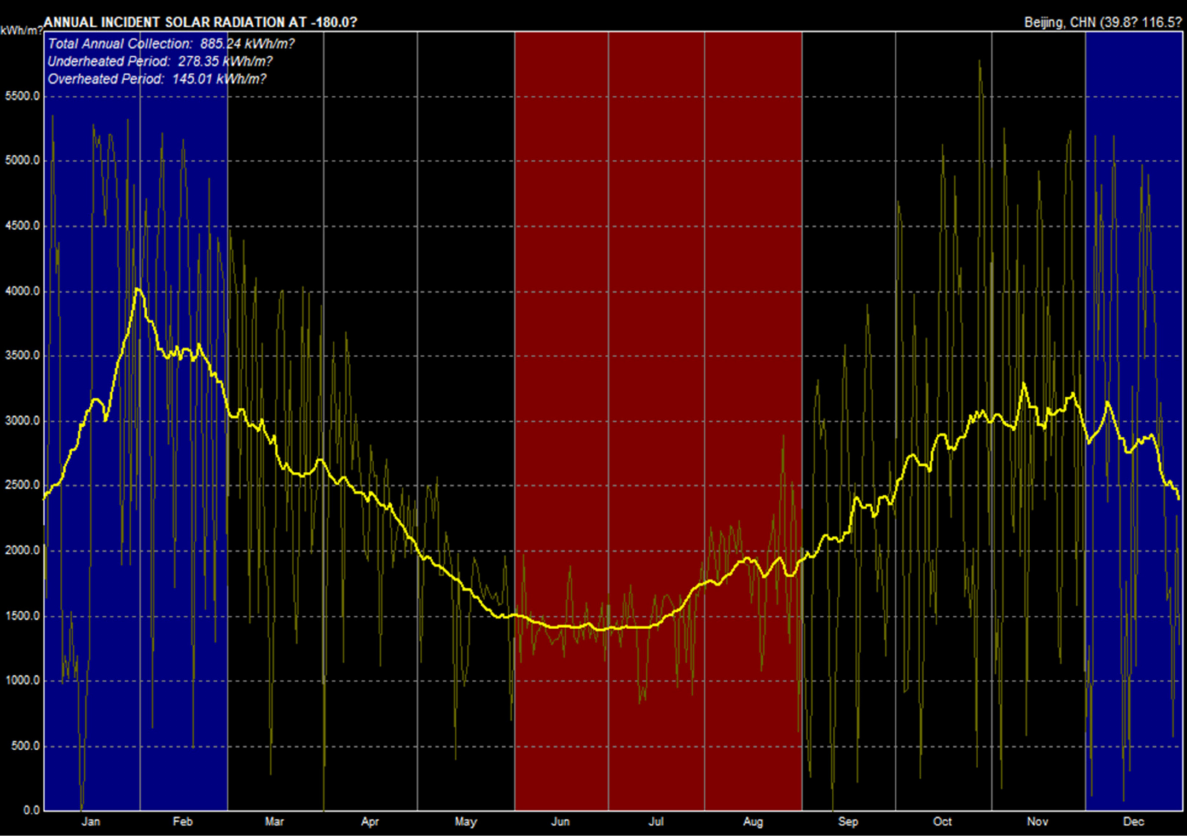
Figure 14. Annual incident solar